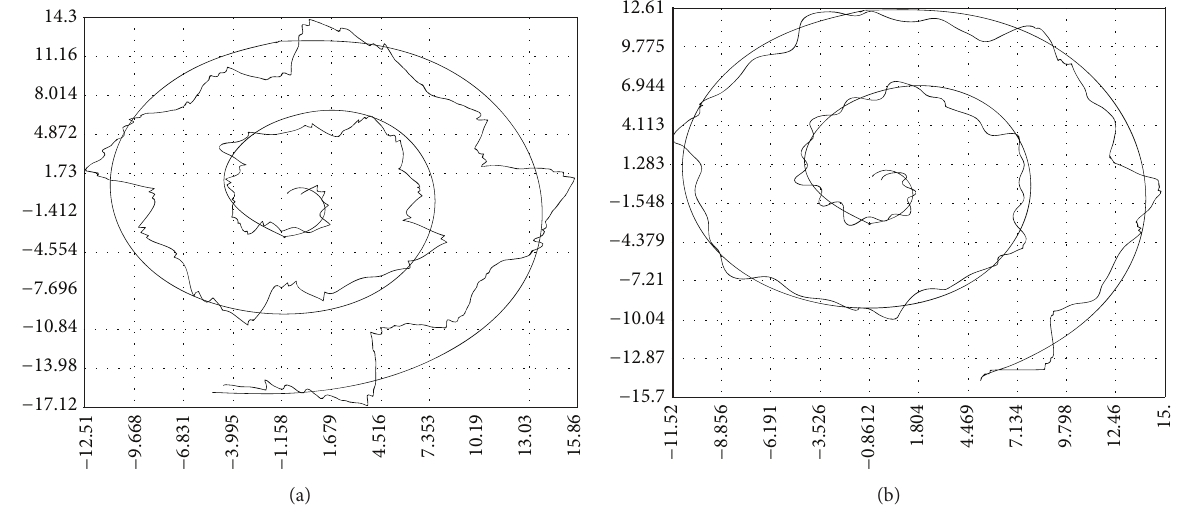
Figure 5: Approximation of vector-function g (𝑡) = (𝑡 cos 𝑡,𝑡 sin 𝑡) , 𝑡 ∈ [0,5𝜋] , by fractal interpolation function g ⋆ with twelve (a) and seventeen (b) points of interpolation